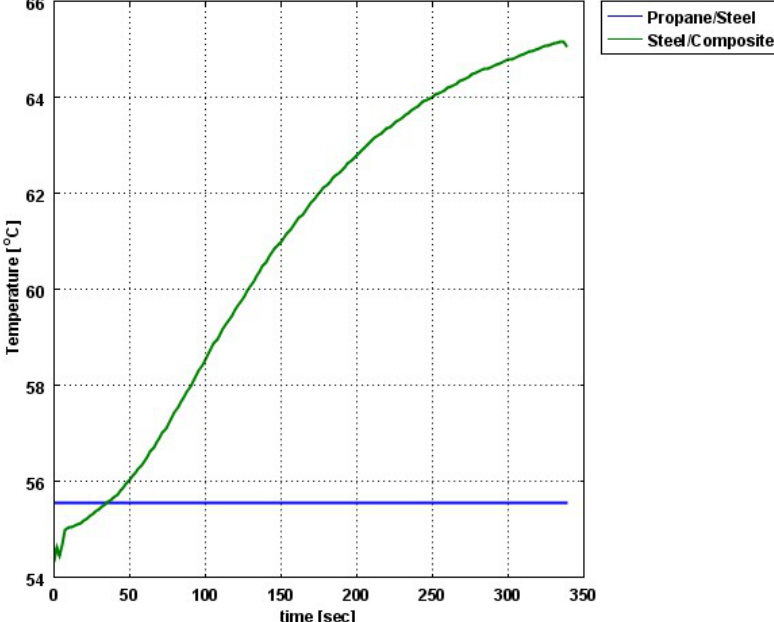
Figure 13. Calculated temperatures at the interface of glass-woven vinyl ester/steel and at the Propane/Steel interface.